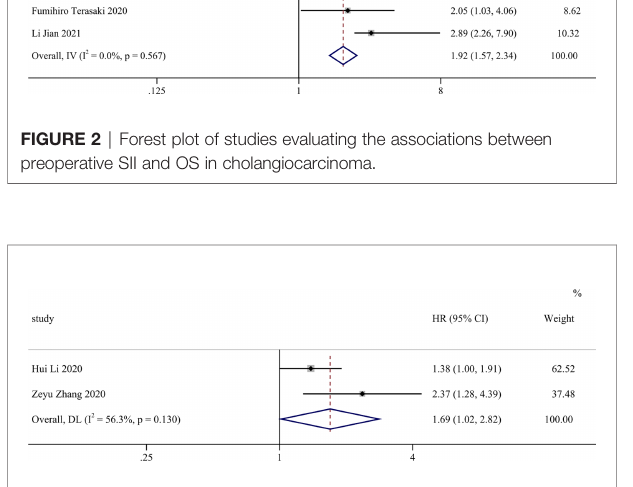
FIGURE 3 | Forest plot of studies evaluating the associations between preoperative SII and RFS in